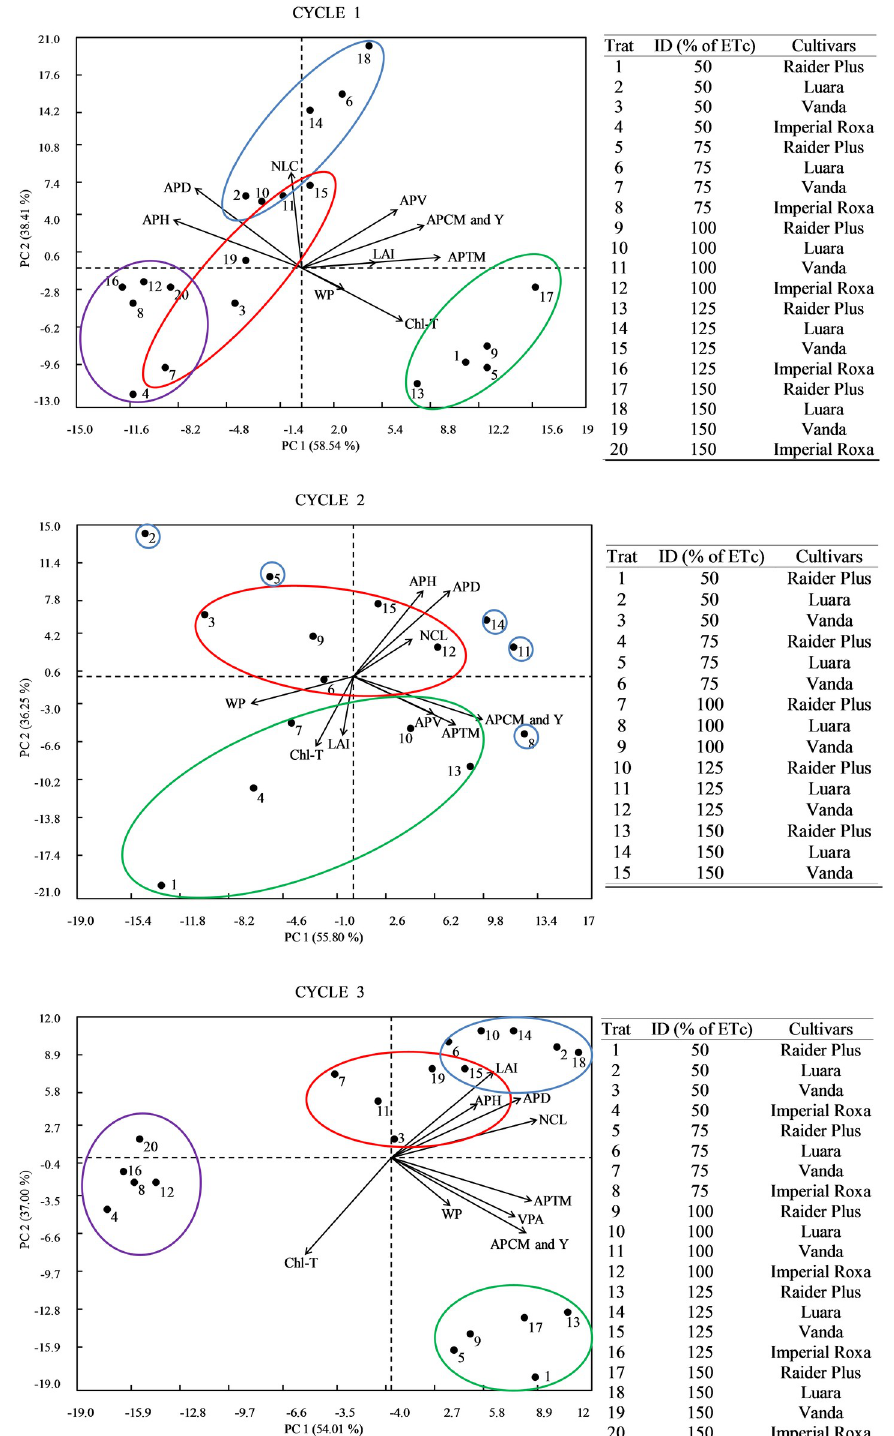
Fig 5. Principal component analysis (PCA) for the aerial part total mass (APTM), aerial part commercial mass (APCM); mass of aerial part loss upon harvesting (MLH), crop yield (Y), water productivity (WP), aerial part height (APH), aerial part diameter (APD), aerial part volume (APV), leaf length (LL), leaf width (LW), fresh leaf mass (FLM), dry leaf mass (DLM), leaf area index (LAI), fresh stem mass (FSM), stem length (SL), stem average diameter (SMD), stem volume (SV) and content of total chlorophyll (Chl-T) in cycles 1, 2 and 3 under